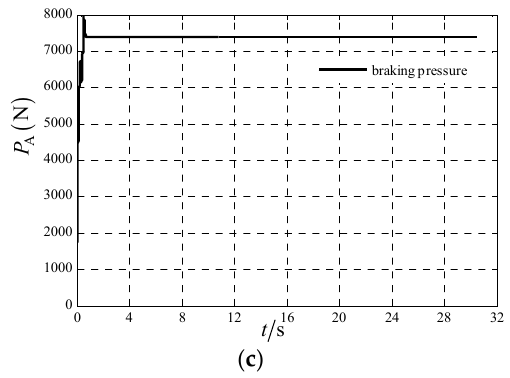
Figure 4. Simulation results of proposed method. ( a ) Aircraft speed and wheel speed; ( b ) Slip ratio; ( c ) Braking pressure.